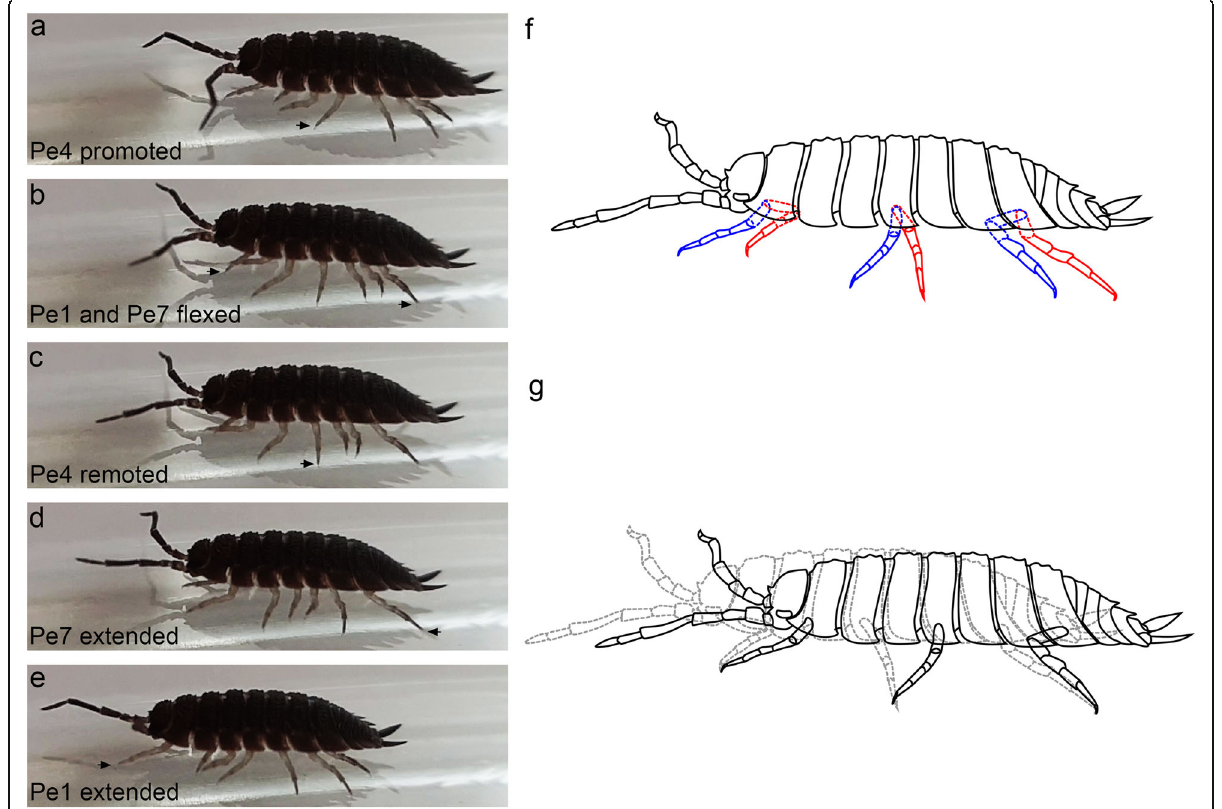
Fig. 7 Locomotion of Porcellio scaber. a-e Images of a walking P. scaber , taken at different time points, showing the extreme positions of pereopods 1, 4 and 7 during their effective strokes. Tips of the pereopods are marked with arrows. f Illustration of the extreme positions of pereopods 1, 4 and 7 during the beginning (blue) and the end (red) of their effective strokes. Podomeres that are partially concealed by the epimeres are shown with segmented lines. While pereopods 1 and 7 employ flexion and extension of their proximal podomeres, pereopod 4 rotates at its base. g Movement of the body relative to the dactyli during the effective strokes of pereopods 1, 4 and 7. The black solid outline shows the starting position, and the gray segmented outline shows the position at the end of an effective stroke. As the pereopods move, they pivot on the